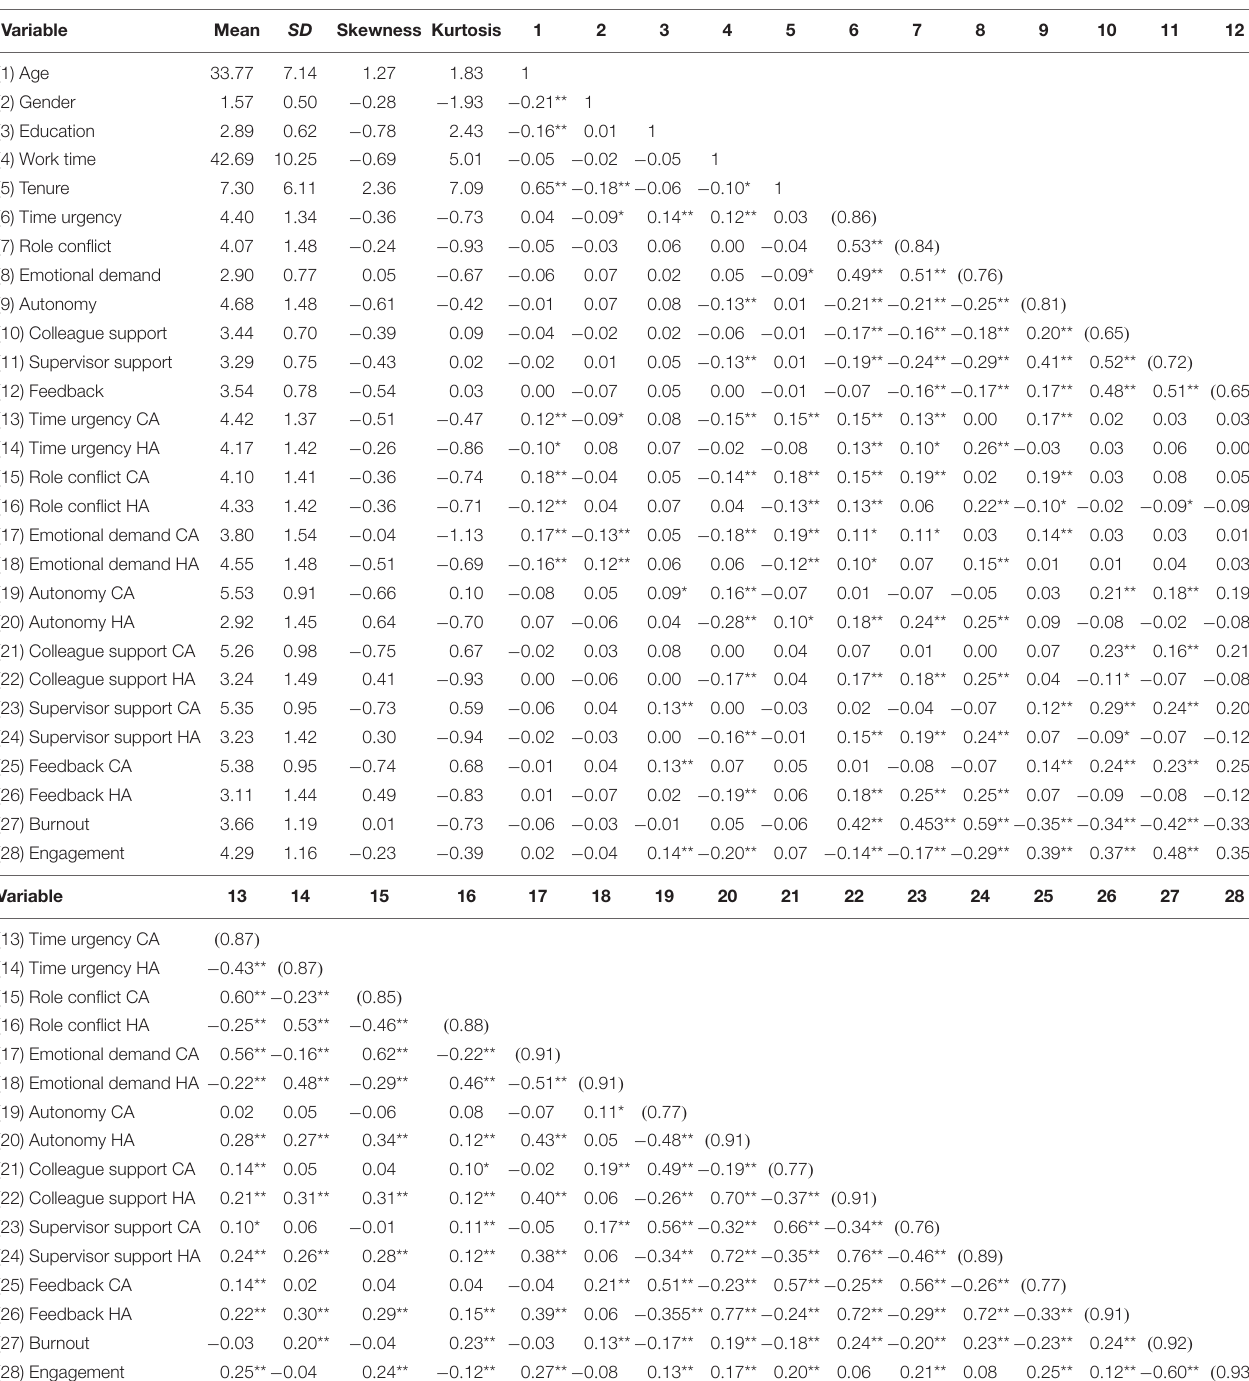
TABLE 2 | Means, standard deviations, and correlations among the study variables in Study 1.